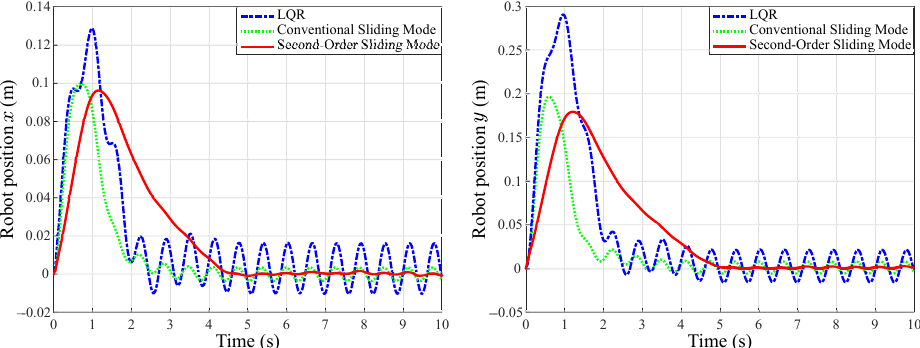
Figure 15. The simulation results with the disturbance compare the robot’s position responses on the X -axis and Y -axis, respectively.